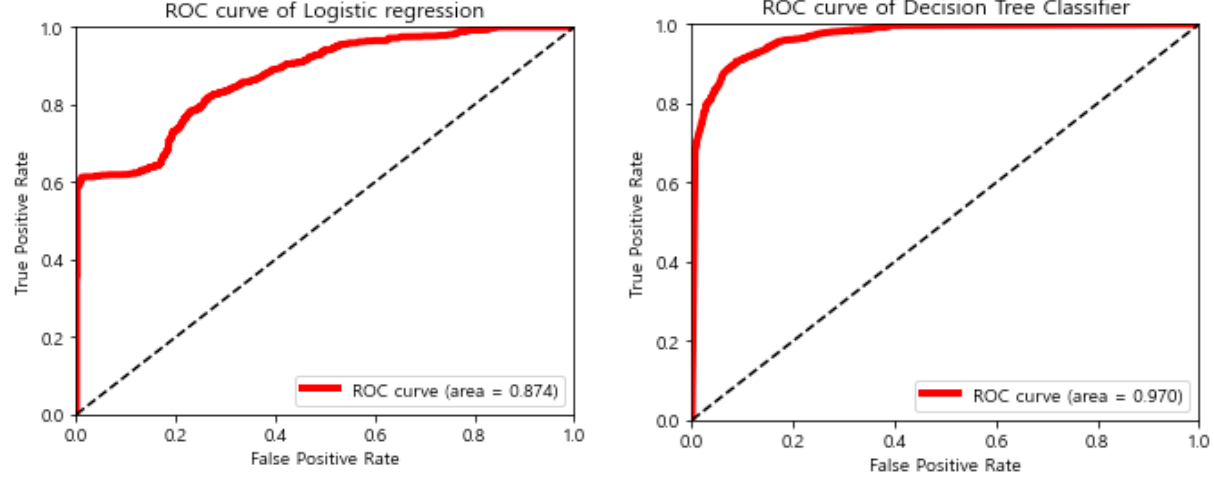
Figure 22. ROC of the logistic regression and decision tree classifiers.